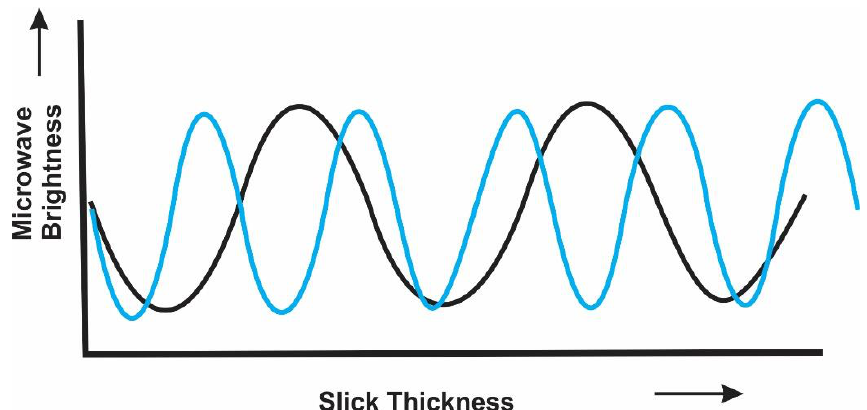
Figure 3. Use of a dual- or higher-frequency microwave system can eliminate some of the uncertainty related to thickness.